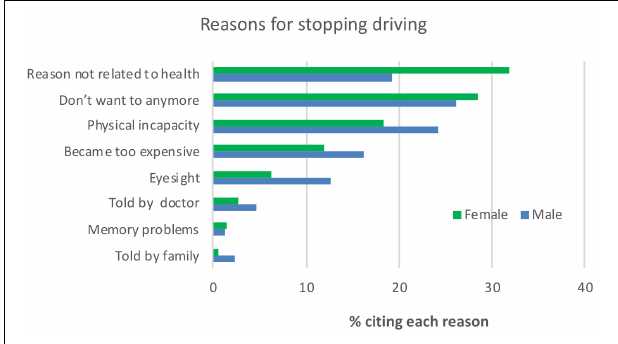
FIGURE 4 | Percentage of participants by Gender who identified each reason for them giving up